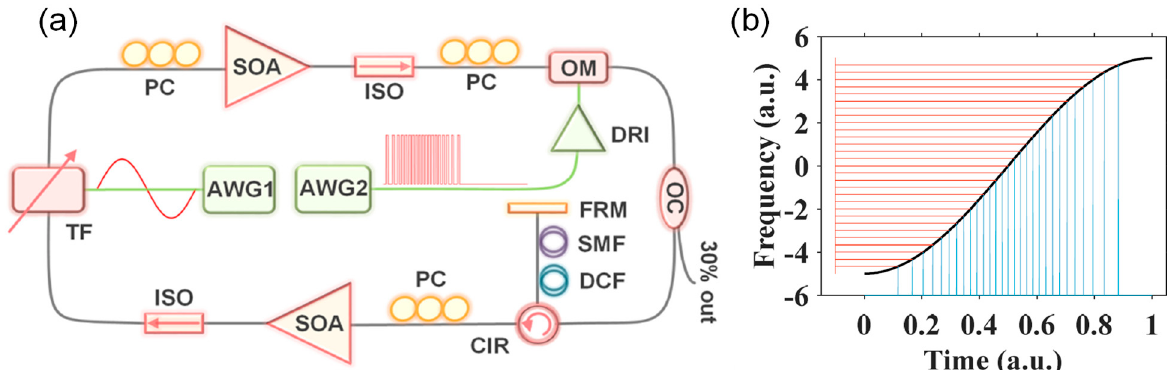
Figure 12. ( a ) Schematic diagram of an FDML laser with time domain modulation and ( b ) the principle of discretization of swept signal with identical comb lines in the frequency domain. The blue solid lines are the rate varying pulses in the time domain and the red solid lines are the corresponding uniform comb lines in the frequency domain. Reprinted with permission from Ref. [87].